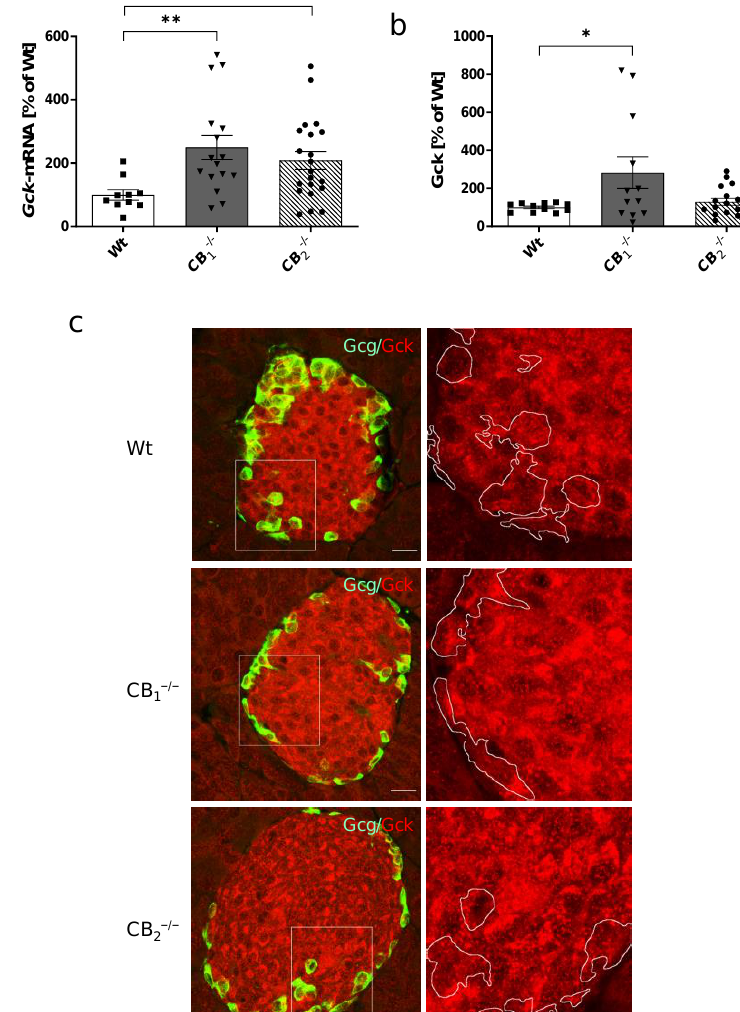
Figure 7. Analysis of glucokinase mRNA ( Gck ) and protein (Gck) in pancreatic tissue of male and female wild-type (Wt) mice and cannabinoid receptor knockout mouse lines (CB 1 − / − , CB 2 − / − ). ( a ) The relative mRNA expression level of Gck was increased in both knockout mouse lines compared to Wt mice ( n = 10–21). ( b ) An increase in pancreatic protein content of Gck was seen only in CB 1 − / − mice ( n = 11–17). ( c ) Immunohistochemical staining of Gck (red) and colabelling of glucagon (Gcg, green) demonstrated labelling of Gck in alpha- and beta-cells with a heterogeneous cytoplasmic labelling surrounding the nuclei in a ring-like manner. As indicated at higher magnification (2.5 fold, right column) of each islet (box), CB 1 − / − mice also showed a heterogeneous Gck distribution pattern with accumulations around the nuclei, with high and low density distribution in the cytoplasmic region. In CB 2 − / − , the heterogeneous detection of Gck was more prominent, displaying distinct accumulations in the perinuclear region with semilunar appearance. In all cases, confocal optical sections were merged and are representative for pancreatic islets of whole pancreatic tissue from three mice per group. Values are presented as mean ( ± S.E.M.) and Wt values were defined as 100%. * p < 0.05; ** p < 0.01; unpaired t -test. Scale bar 20 µm.